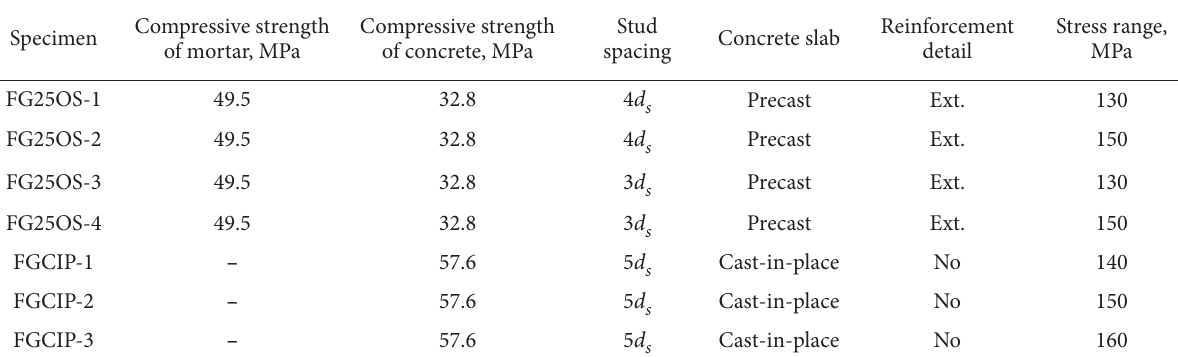
Table 2. Fatigue test